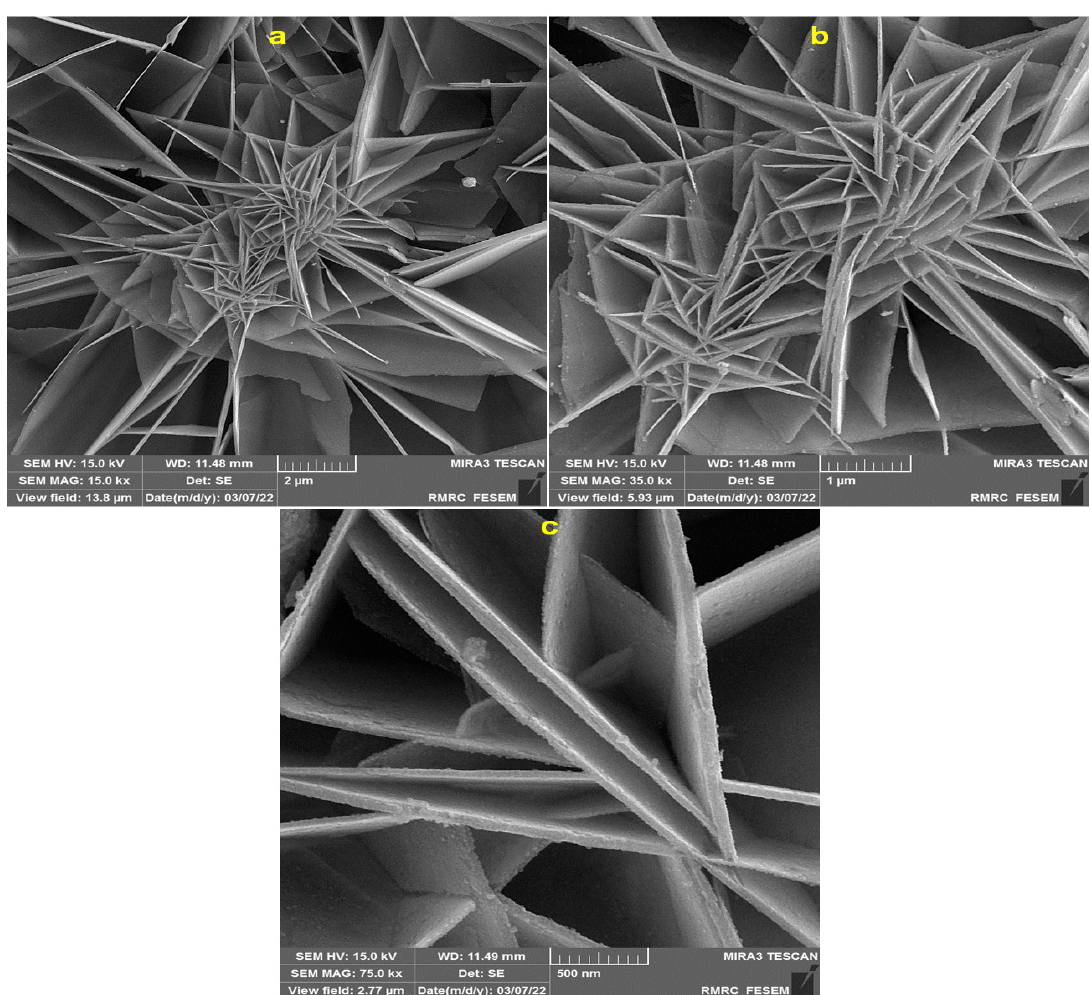
Figure 1. FE-SEM images at diverse magnifications ( a = 2 µm, b = 1 µm and c = 500 nm) for hierarchical flower-like NiCo 2 O 4 nanoplates.